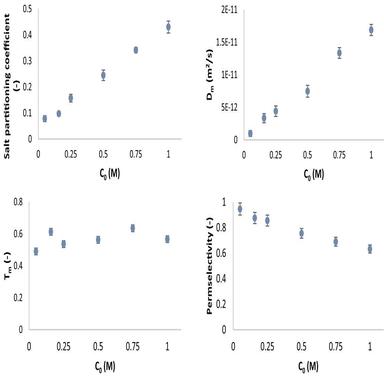
Properties determined for Type 10 Fujifilm AEM.